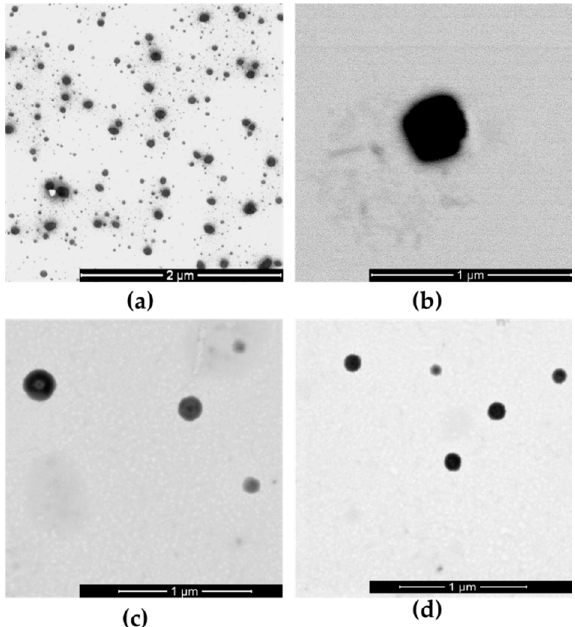
Figure 2. Scanning Transmission Electron Microscopy (STEM) images of hyaluronic acid nanocapsules (HA-NCs). ( a , b ): Formulation without antigen; ( c , d ): ovalbumin-loaded HA-NCs.